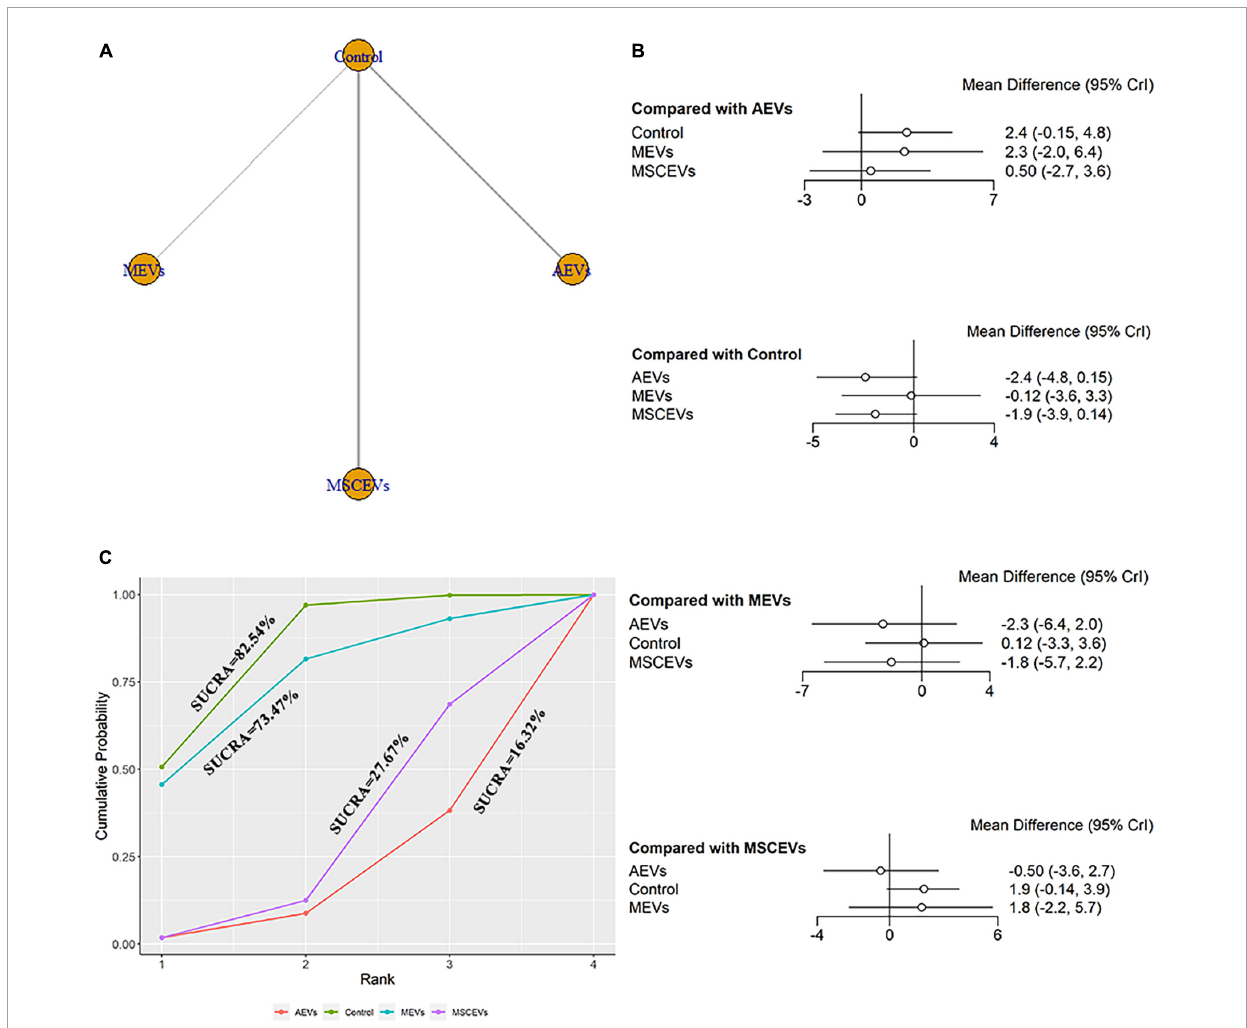
FIGURE3 Comparison of the efficacy of extracellular vesicles (EVs) from different cell sources in modified Neurological Severity Score (mNSS) at day 3 post-traumatic brain injury (TBI). (A) Network plot; (B) Forest plot; (C) Surface under the cumulative ranking curves (SUCRA). AEVs, astrocyte-derived extracellular vesicles; MEVs, microglia-derived extracellular vesicles; MSCEVs, mesenchymal stem cell-derived extracellular vesicles; NSCEVs, neural stem cell-derived extracellular vesicles.